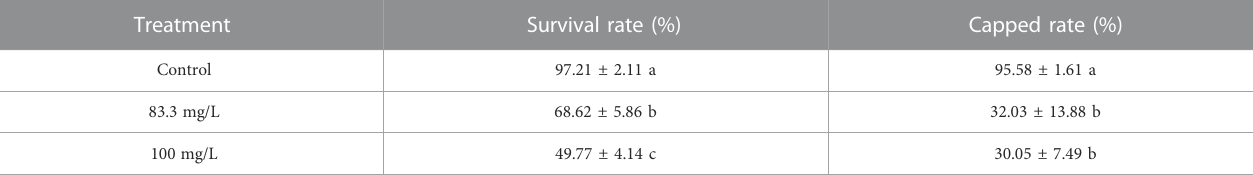
TABLE 2 Effects of pyraclostrobin on the survival rate and capped rate of Apis mellifera larva.